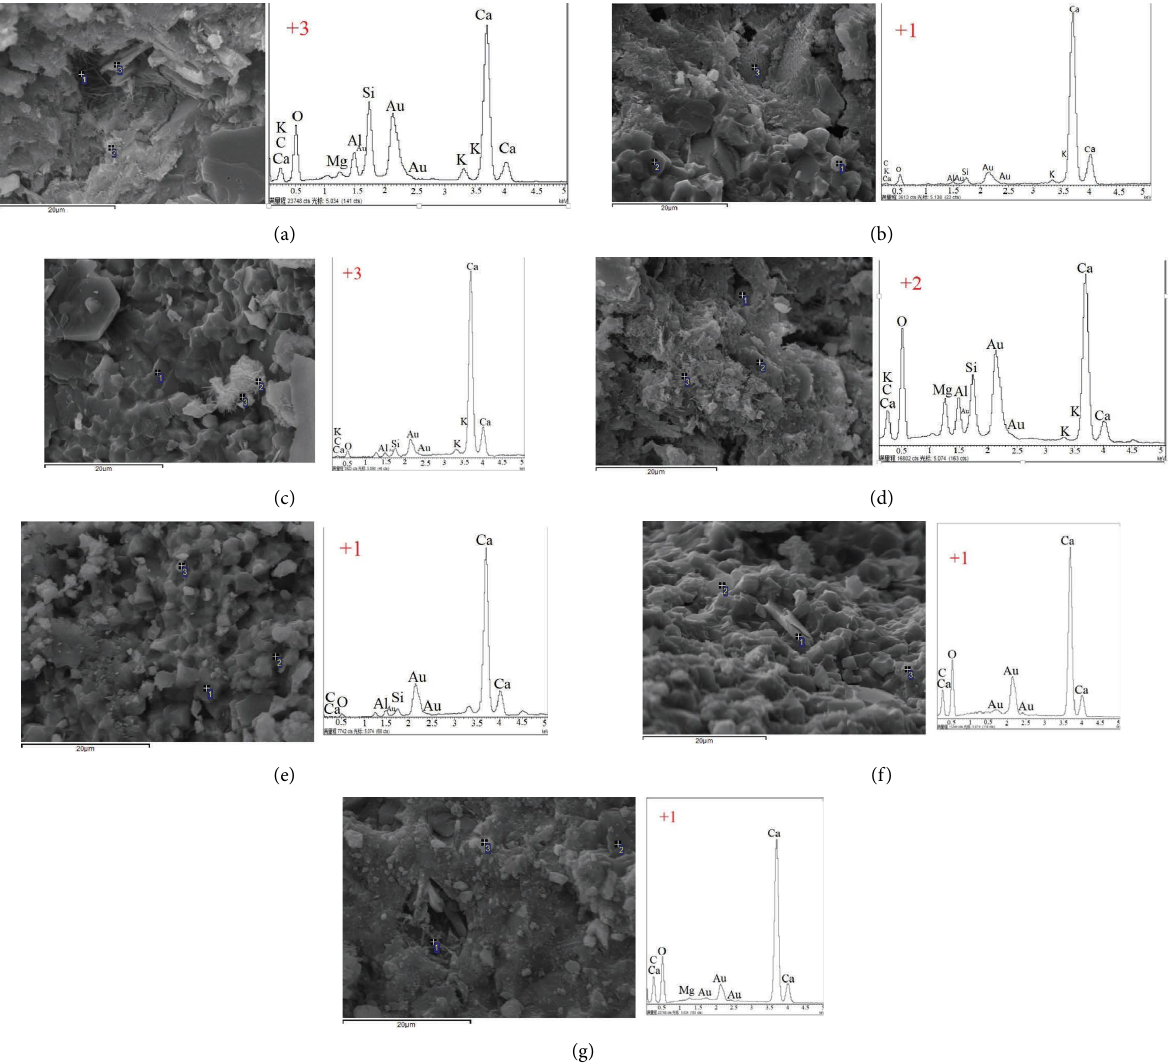
Figure 13: ARGFRC EDS observation (magnify 6000 times points analyses, energy spectrum): (a) EDS-FC0; (b) EDS-FC0.3; (c) EDS-FC0.5; (d) EDS-FC0.8; (e) EDS-FC1.0; (f) EDS-FC1.3; and (g)